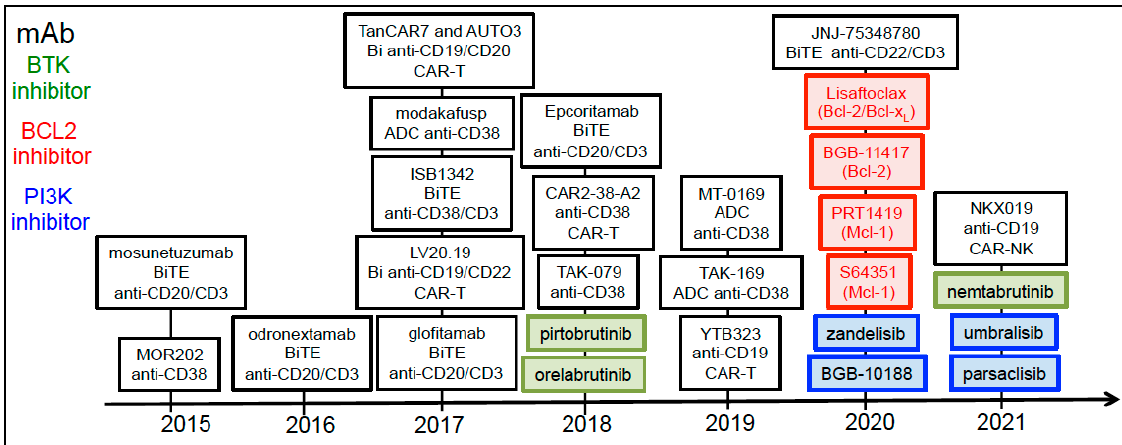
Figure 2. Timeline from 1997 onwards, showing the development of therapeutics for B cell malignancies. ( a ) (1997–2020) Drugs currently approved by the FDA for the treatment of B cell malignancies; ( b ) investigational drugs in clinical development (2013–2021) for B cell malignancies. ADC, antibody–drug conjugate; BCL2, B-cell lymphoma/leukemia 2; BiTE, bispecific T-cell engager, BTK, Bruton tyrosine kinase; CAR-T, chimeric antigen receptor-T cells; PI3K, phosphatidylinositol-3 kinase.